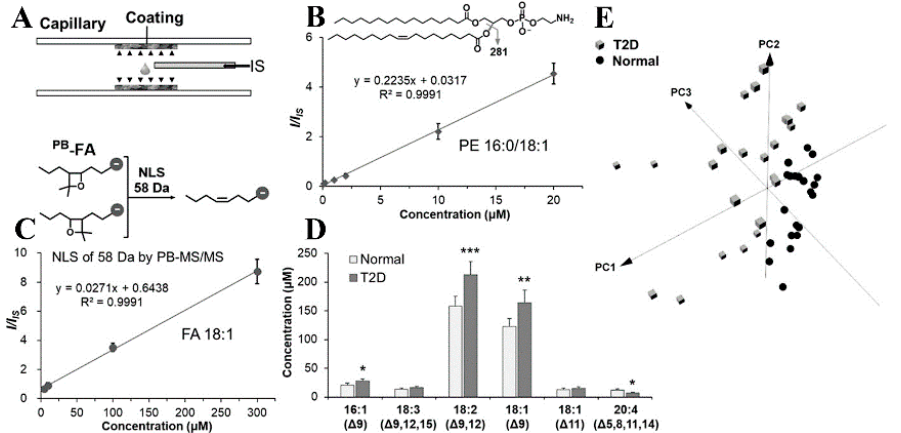
Figure 7. Quantitation of lipids in biofluid samples by PCTE − PB − nanoESI − MS (reproduced from Ref. [48] with permission from Wiley-VCH Verlag GmbH & Co. KGaA, Weinheim). ( A ) Incorporation of internal standards by polymer coating; ( B ) calibration curve of PE 16:0/18:1; ( C ) calibration curve of FA 18:1. Inset shows the fragmentation of derivatized FAs; ( D ) comparison of absolute concentration of some major free FAs in normal and T2D blood samples; ( E ) 3D PCA plot of the data of major free FAs in normal and T2D blood samples. (Note: neutral loss scan (NLS), type 2 diabetes (T2D), * p < 0.05, ** p < 0.01, *** p < 0.001, Student’s t -test).